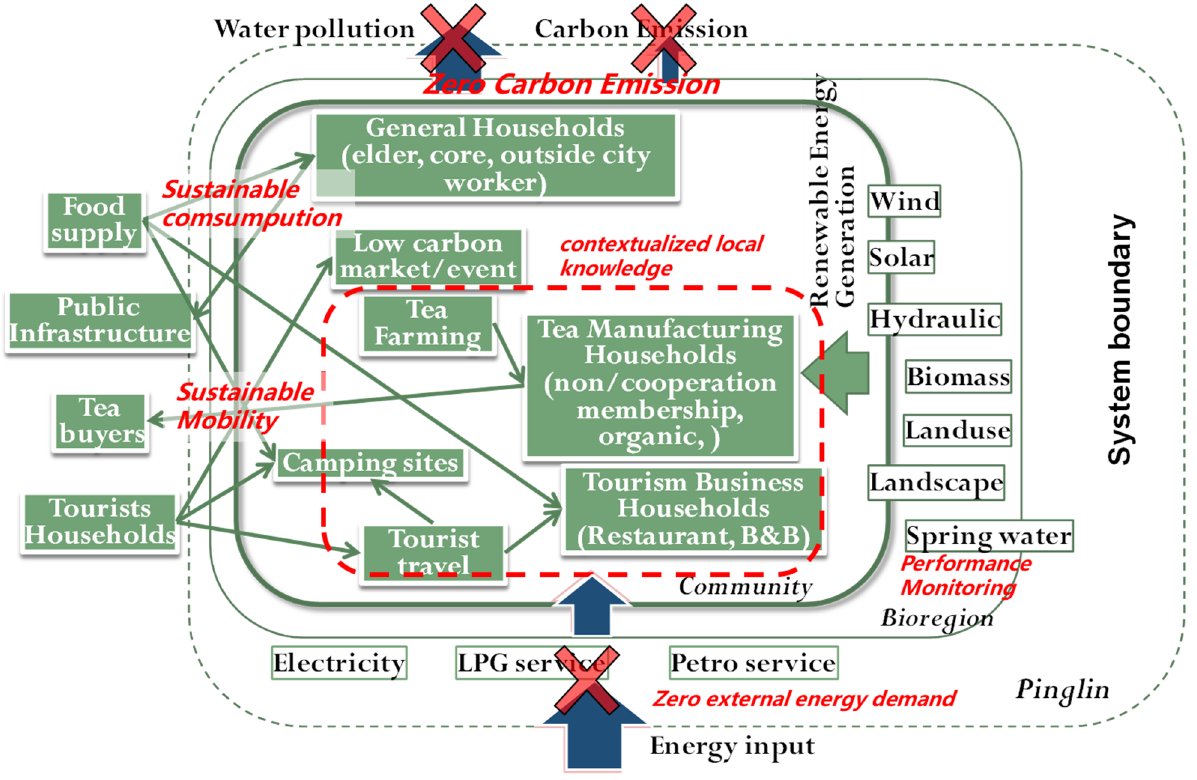
Figure 3. A systematic conception of the relationship between carbon footprint inventories and renewable energy assessments within a system boundary of the Pinglin LCC.